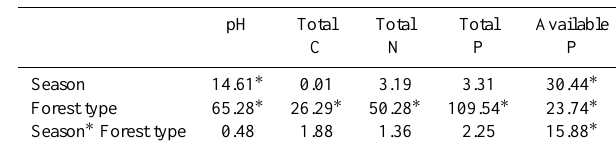
Table 1. Effects of season, forest type and their interactions on soil chemical properties. Numbers are F -values. Stars indicate the level of significance at P < 0 . 05 (no star, not significant at P > 0 .